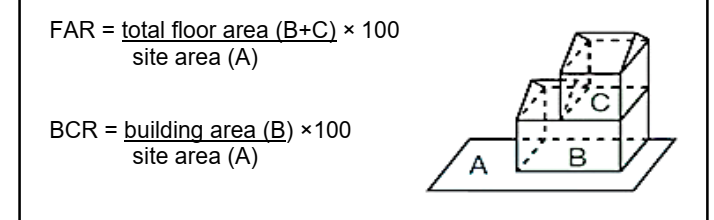
Fig 3. Illustration of FAR and BCR planning standards (UN-Habitat,